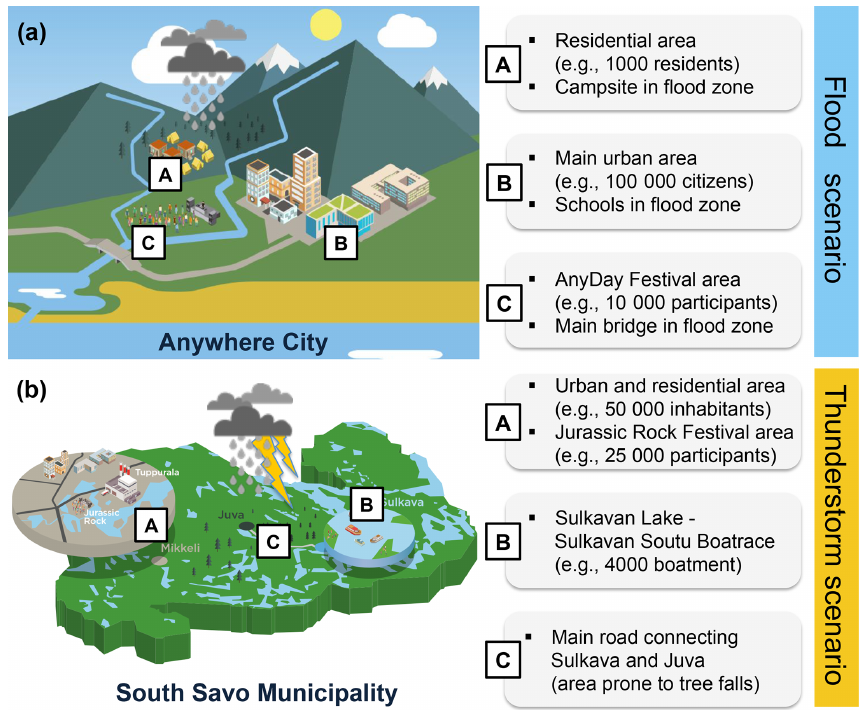
Figure 2. Presentation and brief description of the territory considered in the storyline of ANYCaRE for the (a) flood scenario and (b) strong- wind scenario. Each area of the territories includes attributes for special consideration in the emergency decision-making (e.g. camping, schools, dangerous intersections, industries), representing critical points for intervention in European